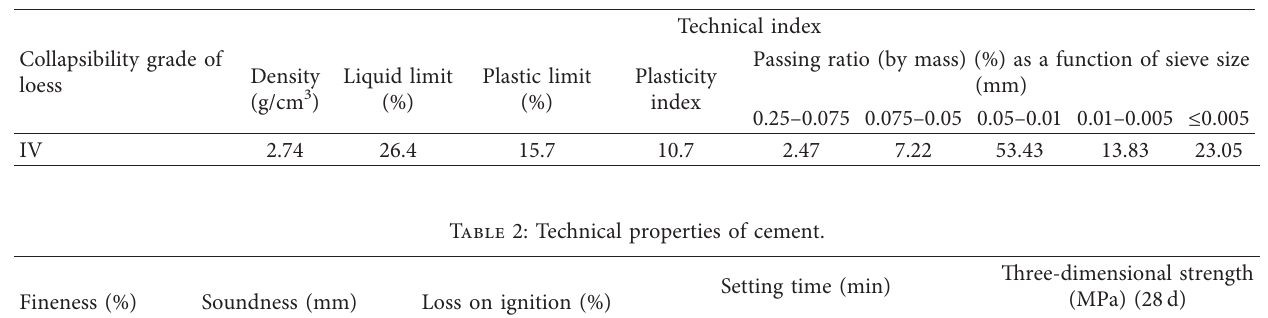
Table 1: Technical properties of loess.